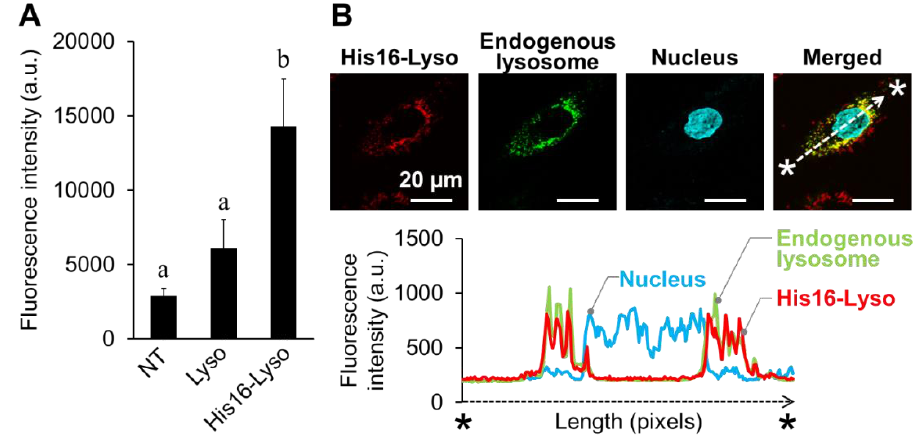
Figure 5. Demonstration experiment for ORT using Fabry disease (FD) patient fibroblasts. ( A ) Cellular uptake of His16-Lyso (10 µM STR-His16, 5.0 µg/mL lysosomes) was evaluated by the mean fluorescence intensity in fluorescence microplate reader analysis (pH 7.4). NT and Lyso mean nontreated condition and unmodified lysosomes, respectively. Data represent means ± SD. Different letters indicate significant differences ( p < 0.05, Tukey’s test). ( B ) Intracellular distribution of His16-Lyso in FD patient fibroblasts. Red, green, and cyan fluorescence indicates His16-Lyso, endogenous lysosomes stained with LysoTracker Green, and nuclei stained with Hoechst 33258, respectively. The distributions of His16-Lyso, endogenous lysosomes, and nuclei were quantified by measuring the fluorescence intensities along the line between the two asterisks.